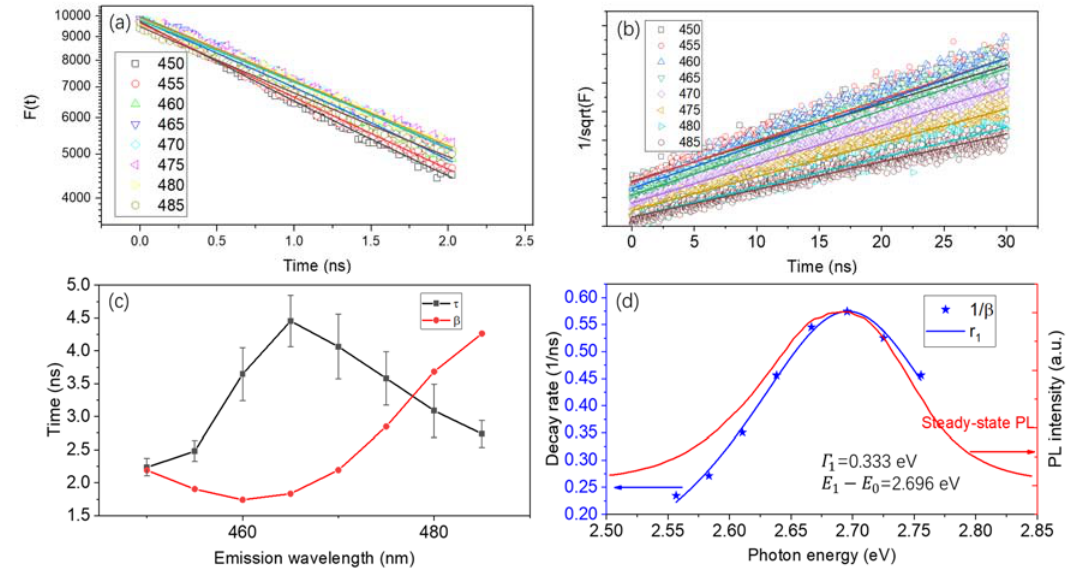
Figure 5. ( a ) The first stage of the PL decay curves fitted by simple exponential functions. ( b ). Linear fittings of 1 (cid:3493) 𝐹(cid:4666)𝑡(cid:4667)⁄ versus t at the first stage area. ( c ) Fitting parameters as a function of detection wavelength. Black squares: τ ; red circles: β . ( d ) The relationship between 1/ β (blue star) and photon energy is fitted by equation 6 (blue line). The steady sate spectrum (red line) is added for comparison.